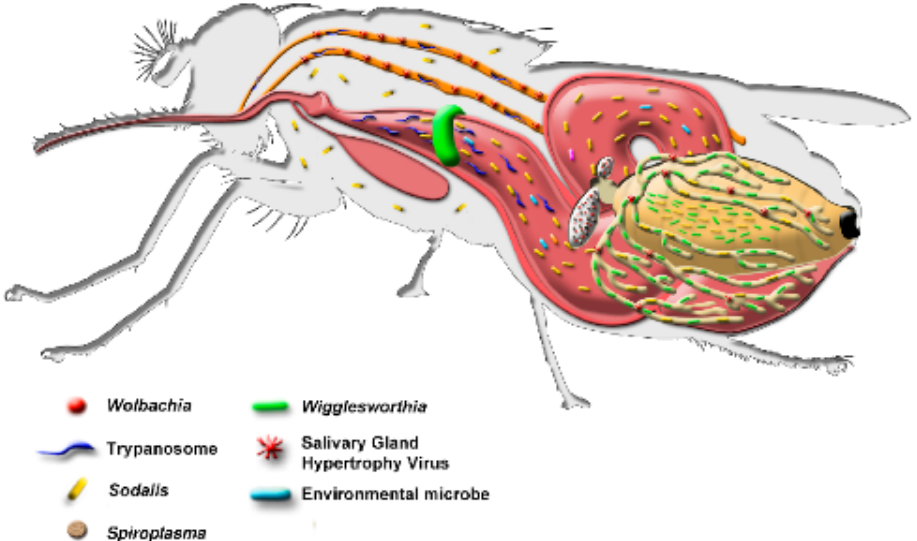
Figure 4. The tsetse fly and its associated microorganisms. Figure adapted with permission from [116,117].